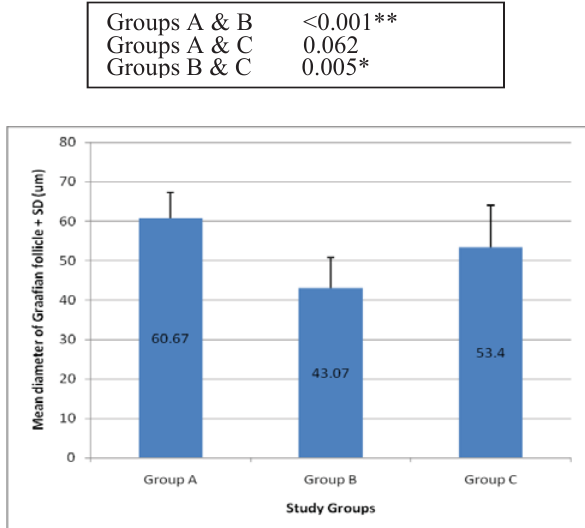
Fig-1: Diameter of Graafian follicle measured for control group A, experimental group B and C (error bar represents standard deviation).